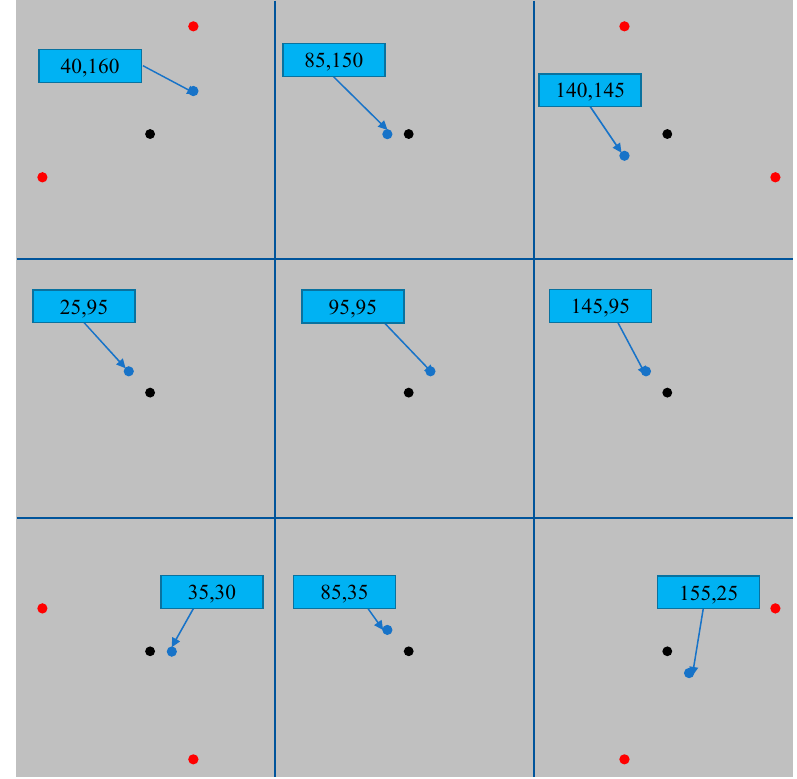
Figure 10. Test set position slightly off-center.